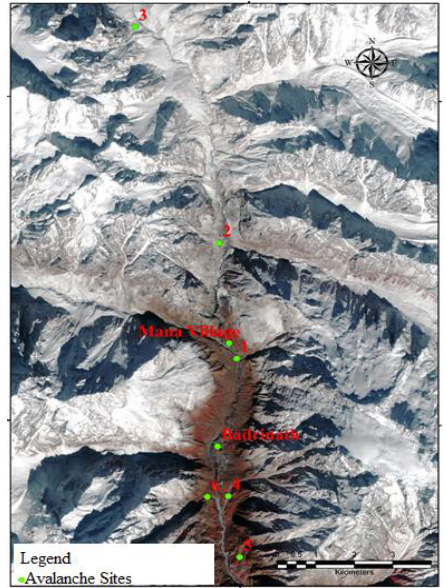
Figure 3 Location of avalanche sites where avalanche has occurred (Sentinel-2 image, 28-11-2017).